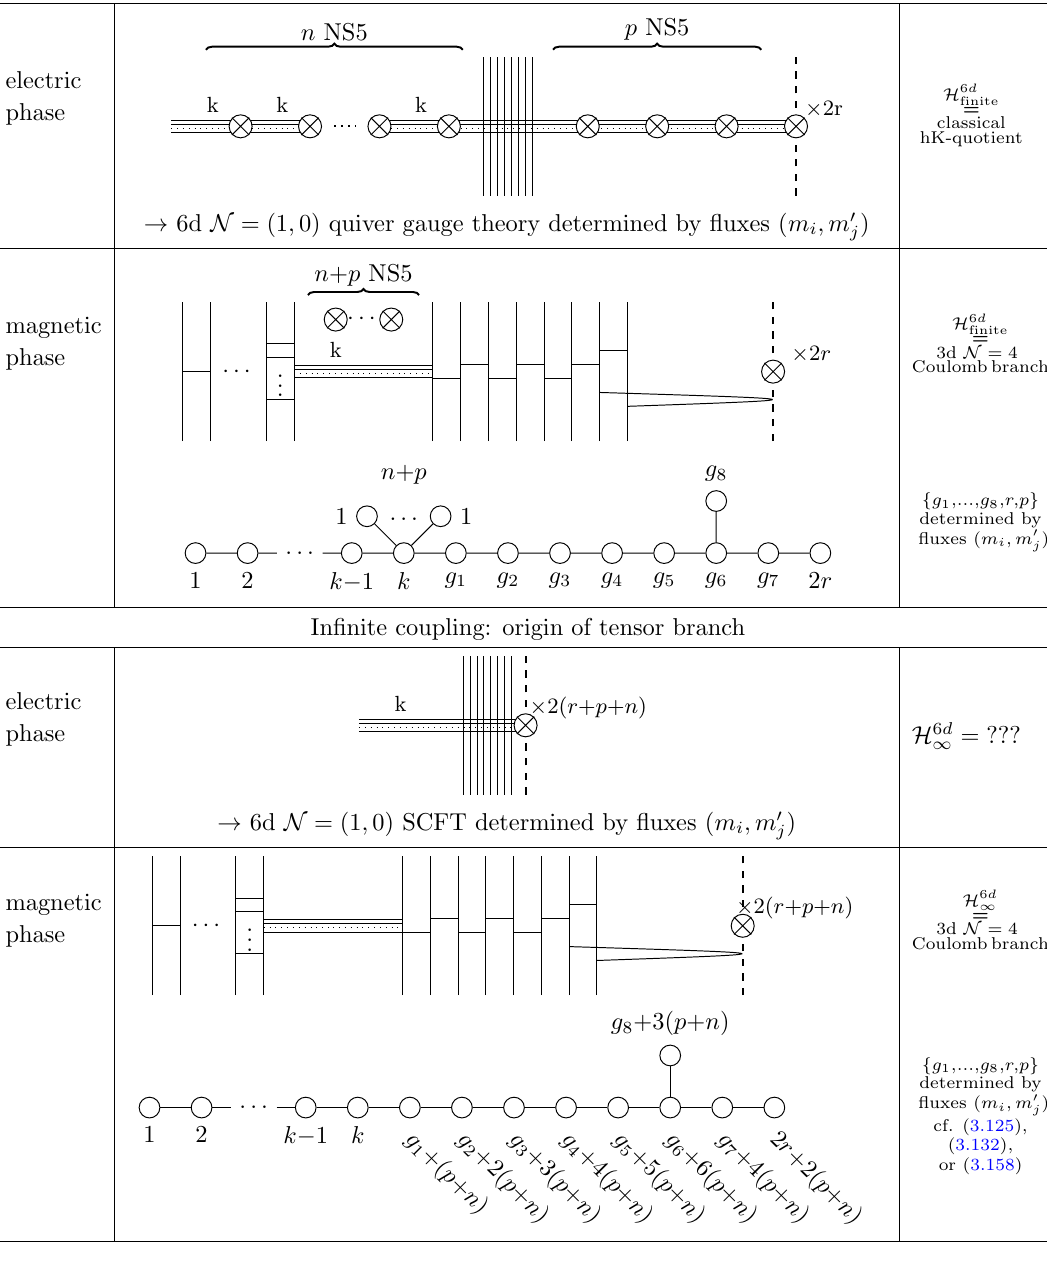
) determines the brane j